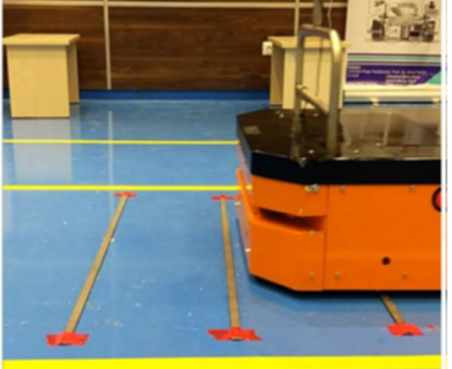
Figure 2. Electrical motor use-case test bed implemented for verification of the PdM platform for condition monitoring applications.